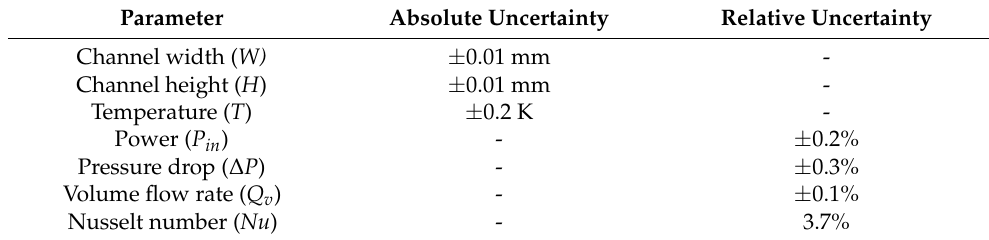
Table 6. Uncertainty data of parameters.